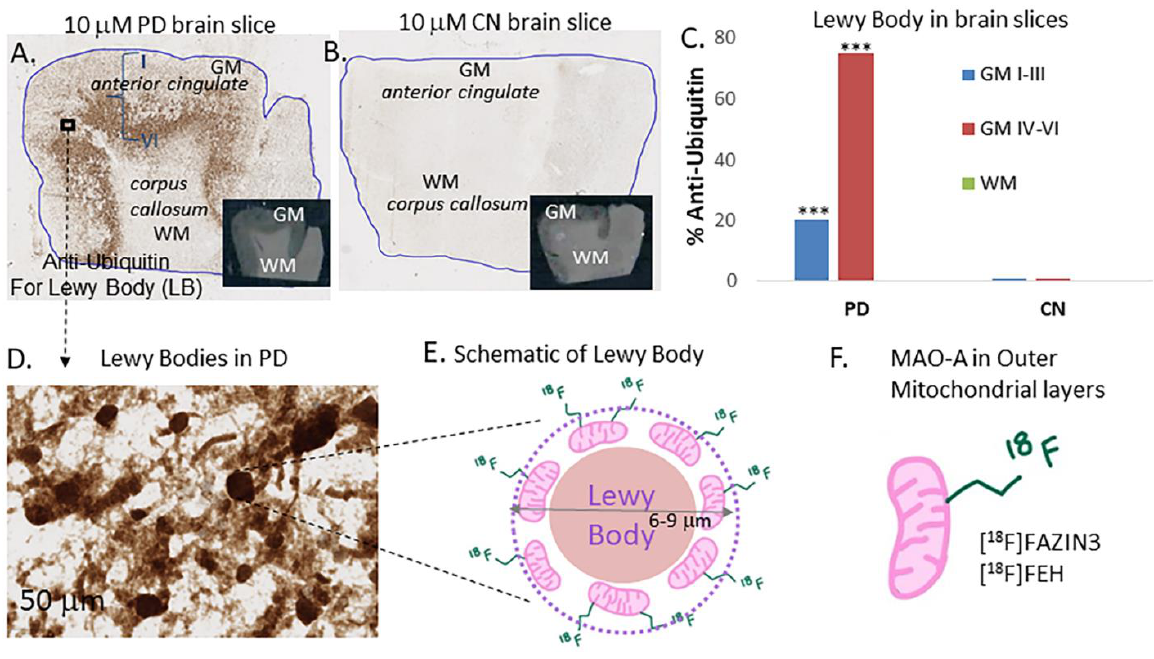
Figure 1. Lewy body: ( A ). Brain slice from PD subject #11-88 stained with anti-ubiquitin (UIHC) showing LB in the grey matter (GM) regions (inset shows scan of 10 μm brain slice); ( B ). Brain slice from control subject shows lack of staining by anti-ubiquitin, confirming absence of LB (inset shows scan of 10 μm brain slice); ( C ). Plot shows percent of anti-ubiquitin in GM cortical layers I – III and GM layers IV – VI in PD subjects and control subjects. High percentages of LB were present in PD IV – VI while lower amounts were present in PD I – III and no LB in PD WM. Control subjects GM and WM showed no LB (*** p < 0.001 for cortical layers versus WM and CN GM); ( D ). Magnified view of GM showing LB in the PD brain slice; ( E ). Schematic view of LB in the inset with a diameter range of 6 to 9 microns consistent with reported measures showing LB surrounded by mitochondria, and a potential target for fluorine-18 labeled PET imaging agent; ( F ). Monoamine oxidase A in the outer layer of mitochondria as a potential biomarker, using [ 18 F]FAZIN3 and [ 18 F]FEH.